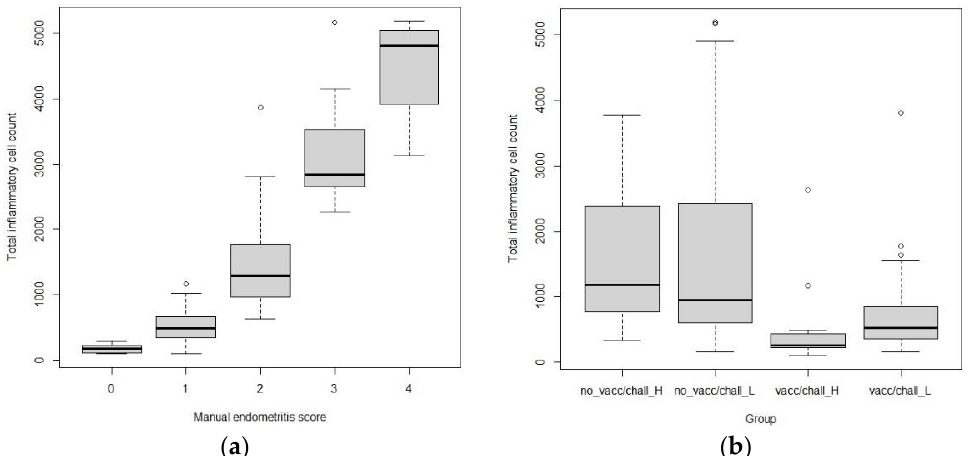
Figure 5. Distributions of total inflammatory cell counts. The boxplots of total inflammatory cell counts show the separation of examiner 1′ s manual endometritis grades ( a ) and the markedly different distributions of total inflammatory cell counts between the vaccinated and unvaccinated groups ( b ). The circles above the bars are individual cases with substantially higher cell numbers.